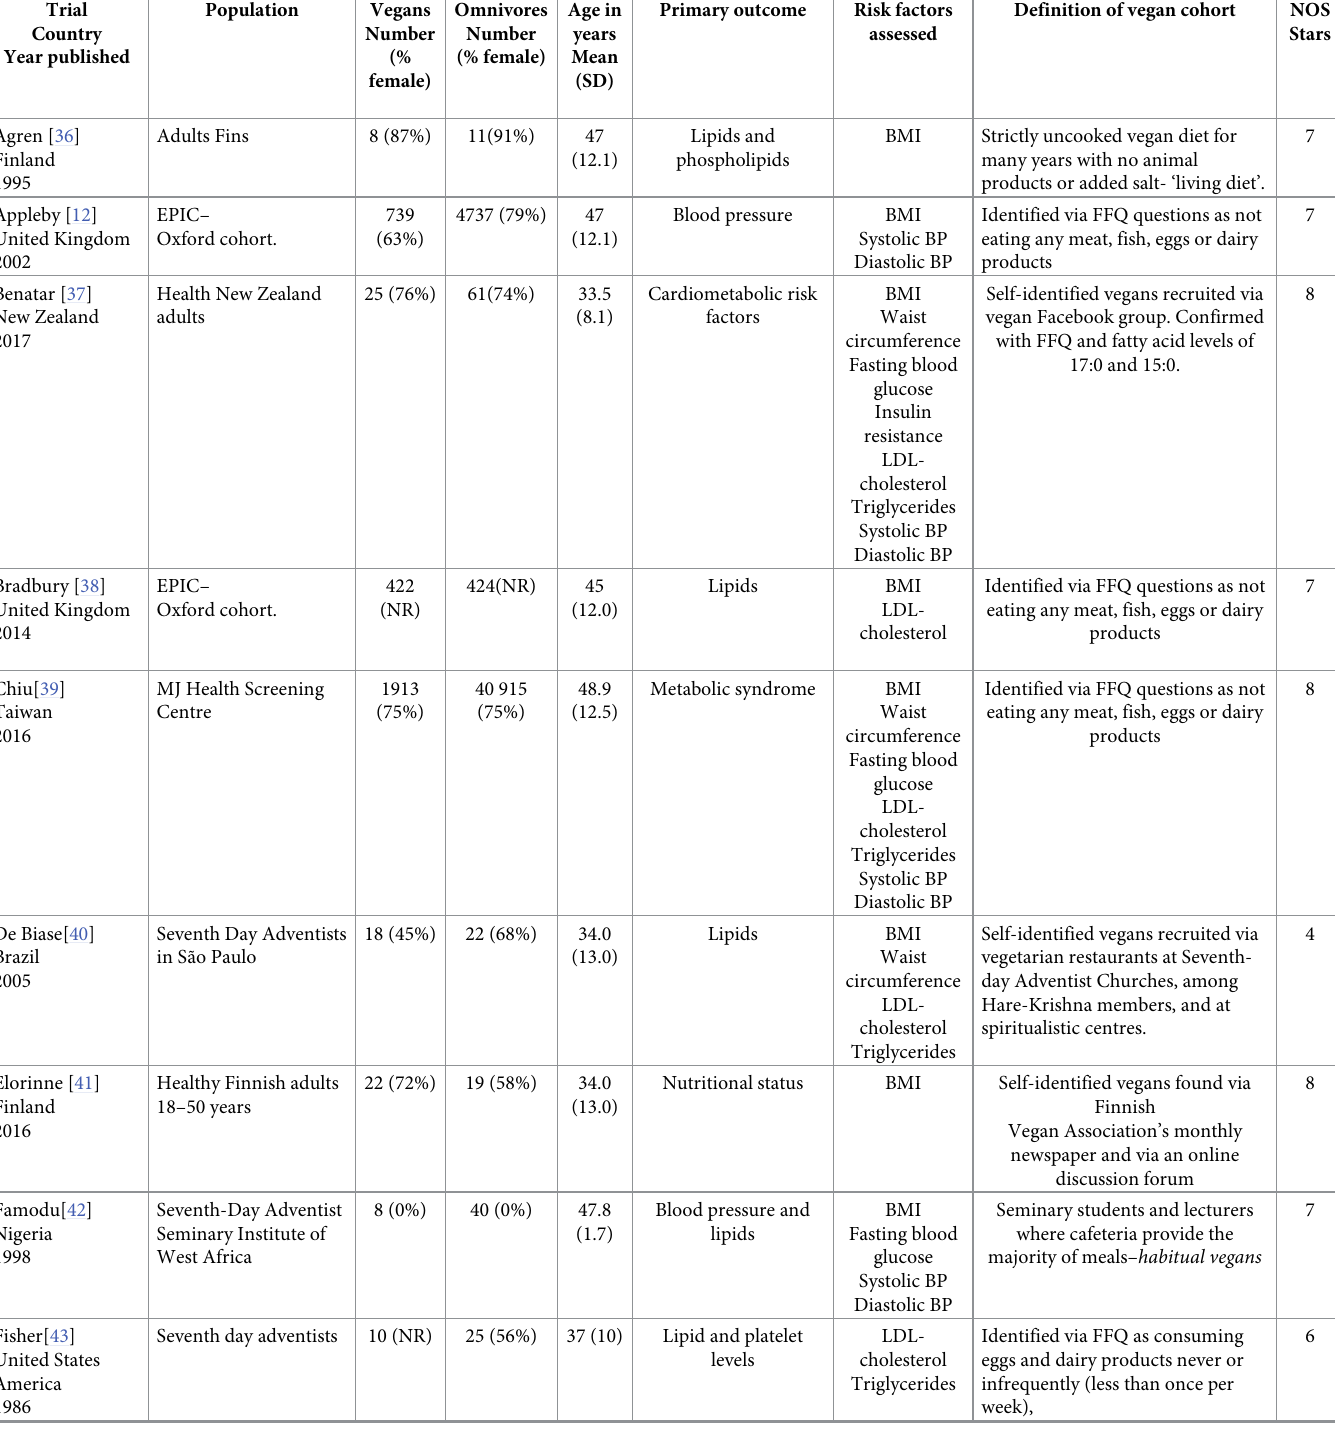
Table 1. Cross sectional studies included in the